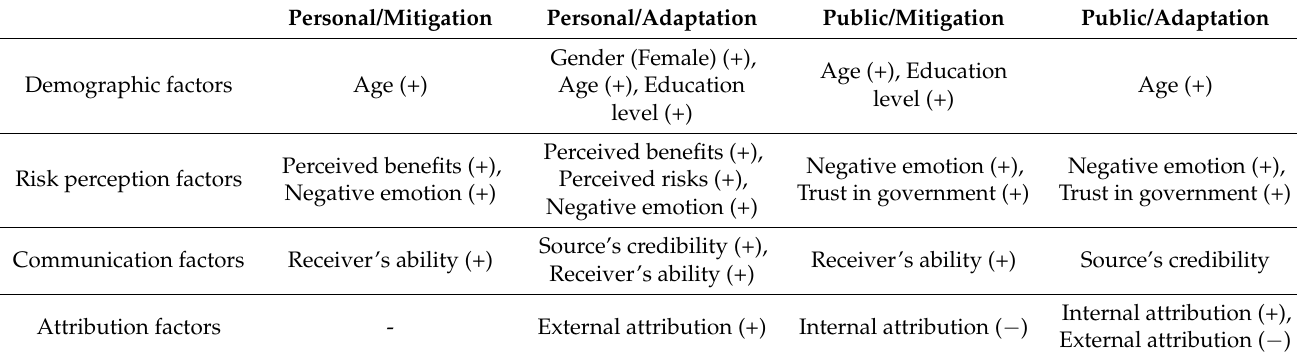
Table 7. Summary of multiple regression analysis